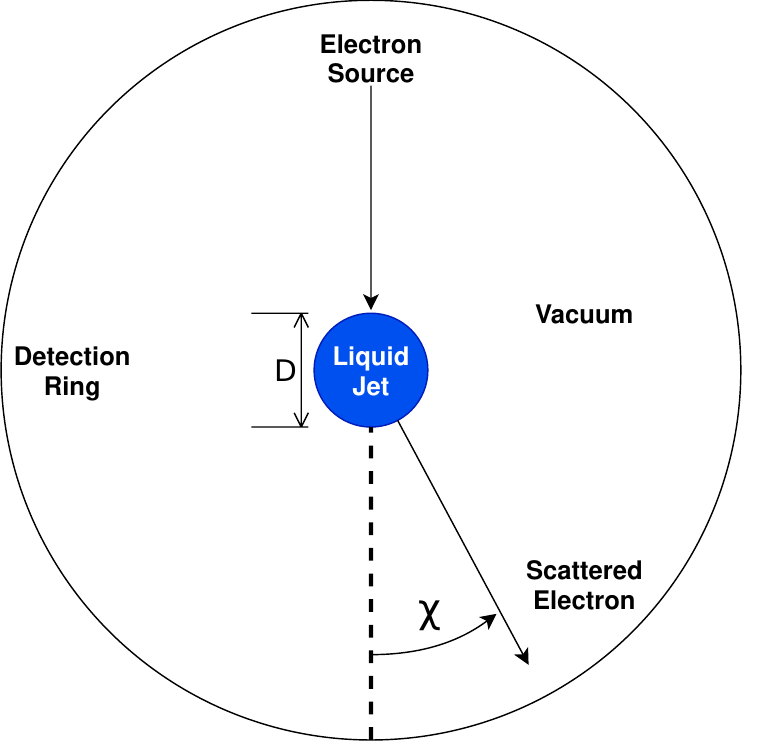
Figure 1. Diagram of crossed-beam electron scattering from a liquid micro-jet. The liquid is propelled into the page, while detectors are positioned normal to the liquid